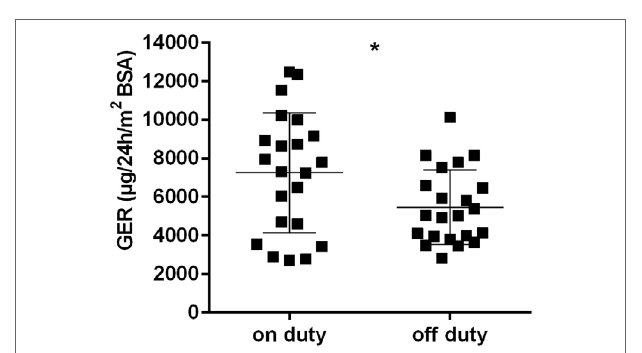
FigUre 2 | Glucocorticoid excretion rates [ μ g/24 h/m 2 body surface area (BSA)] in all physicans, on and off duty; horizontal bars indicate mean and SD; * p < 0.01.